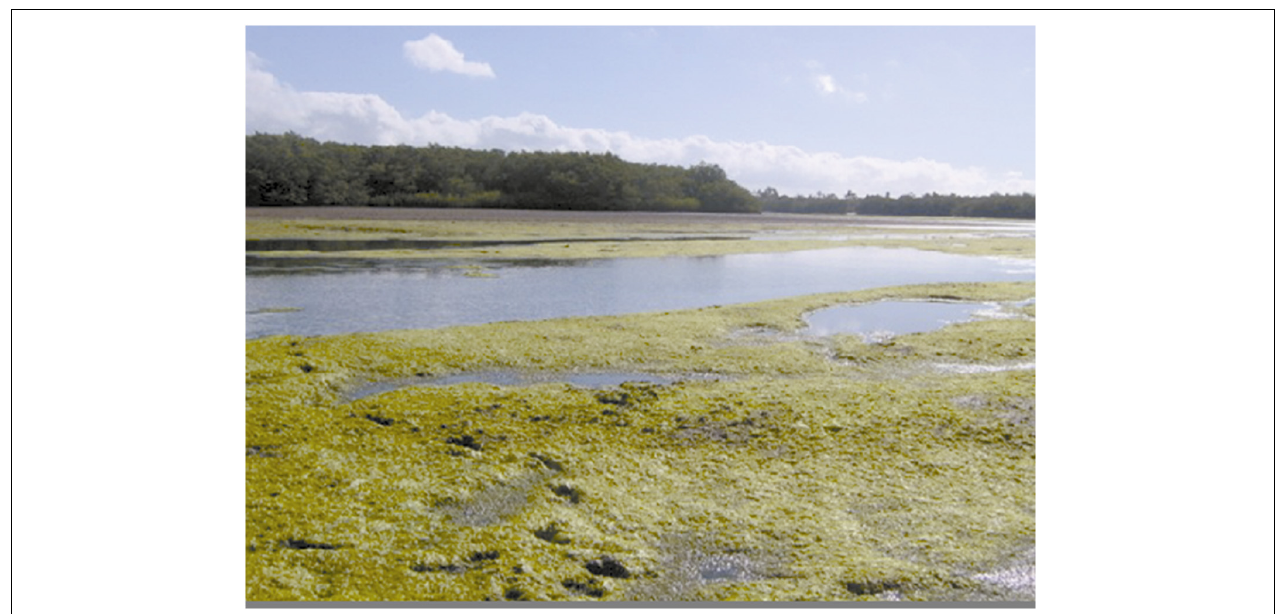
FIGURE 4 | Extensive algal bloom resulting from excess nutrients from shrimp farm effluents in the Jaguaribe River Estuary, Northeast